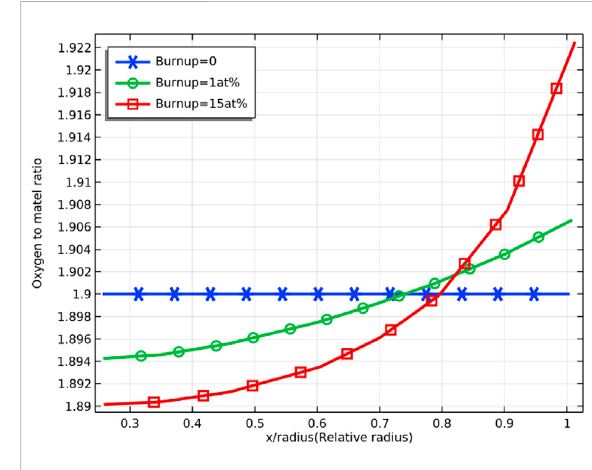
FIGURE 5 Radial distribution of oxygen/metal ratio at 0, 1 at% and 8 at% fuel burnup (with oxygen/metal ratio of 1.90)